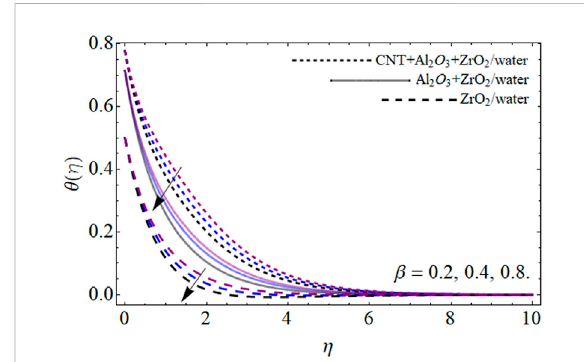
FIGURE 10 Energy outlines θ ( η ) versus thermal radiation Rd